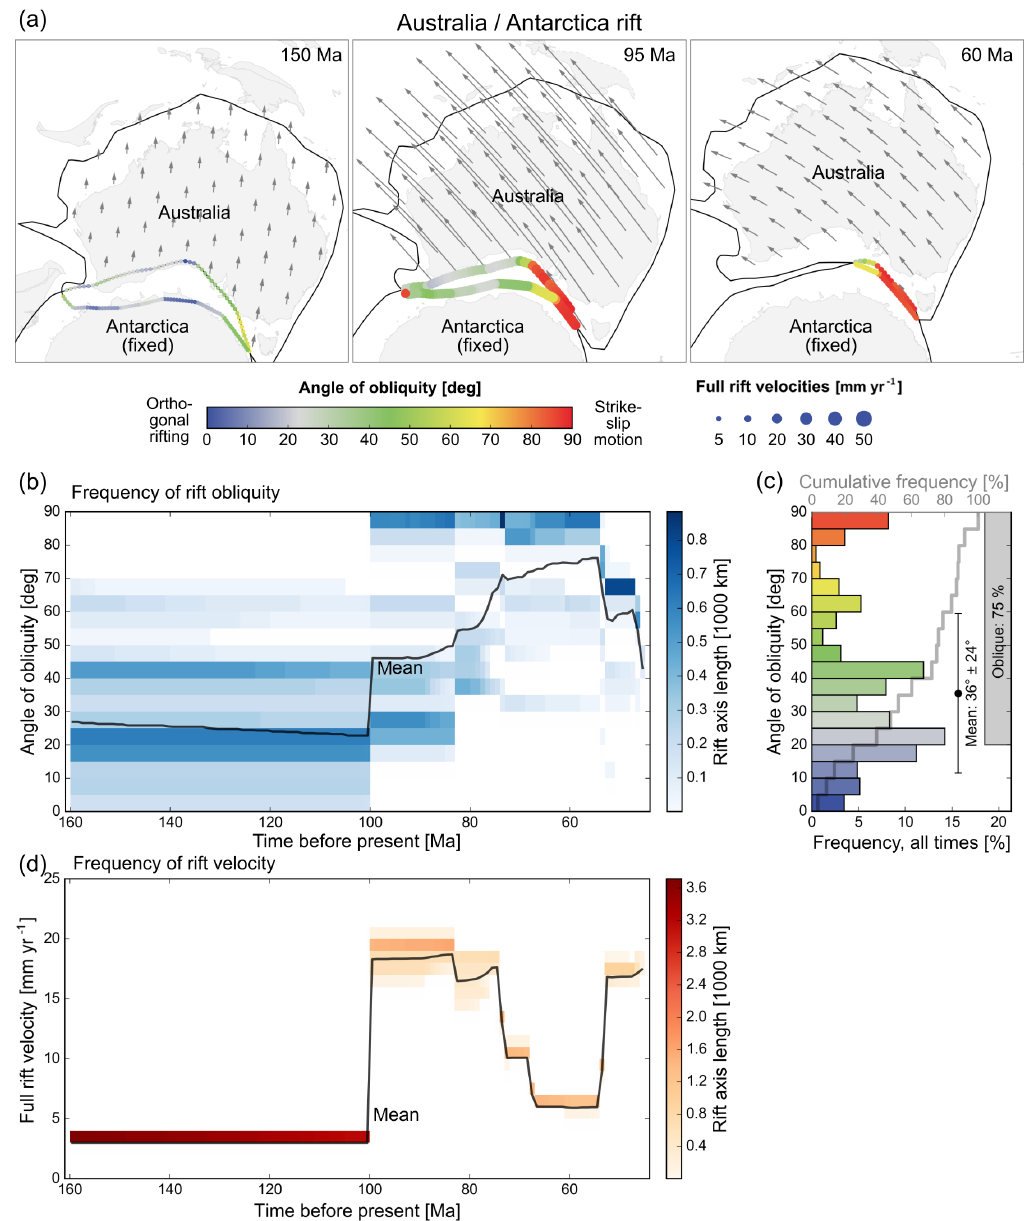
Figure 6. Australia / Antarctica rift. A distinct change in plate motion takes place at 100Ma generating two discrete phases: (1) slow rifting at moderate obliquity and (2) fast rifting at high obliquity. For explanation of symbols and diagrams see caption of Fig.